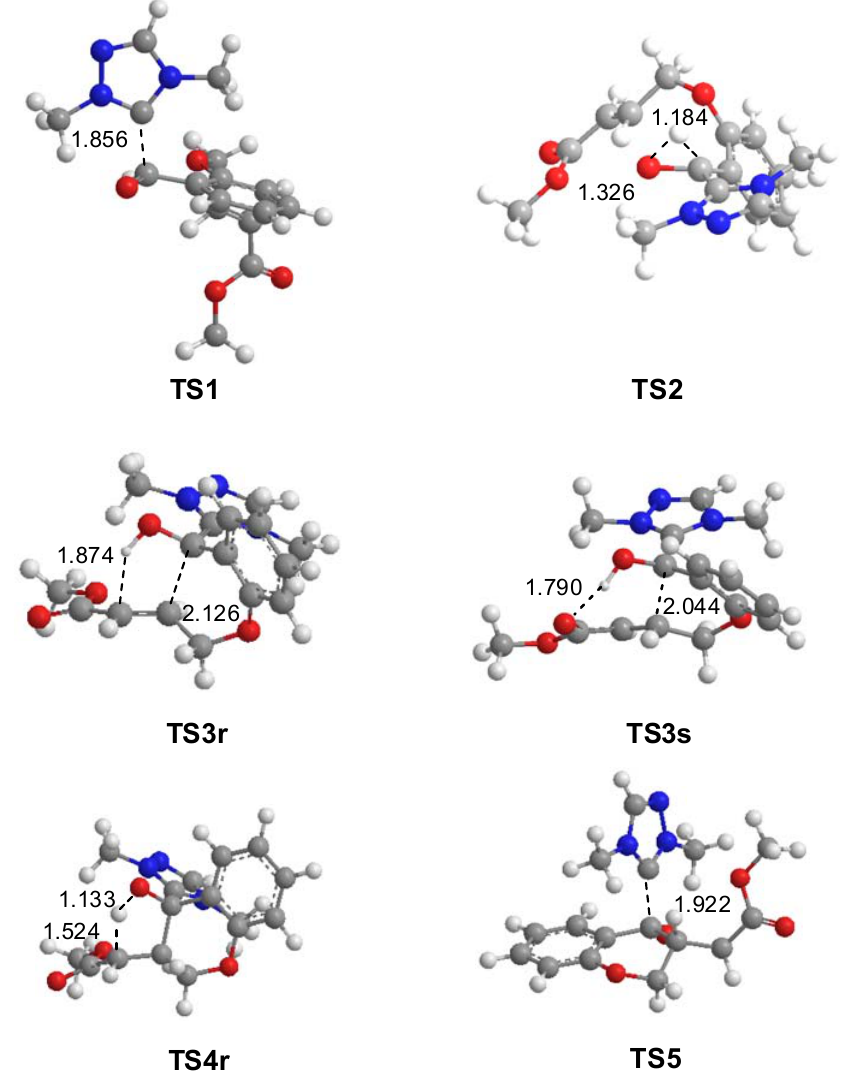
Figure 2. Transition structures associated with the NHC-catalyzed intramolecular Stetter reaction of salicylaldehyde 1 . The distances are given in